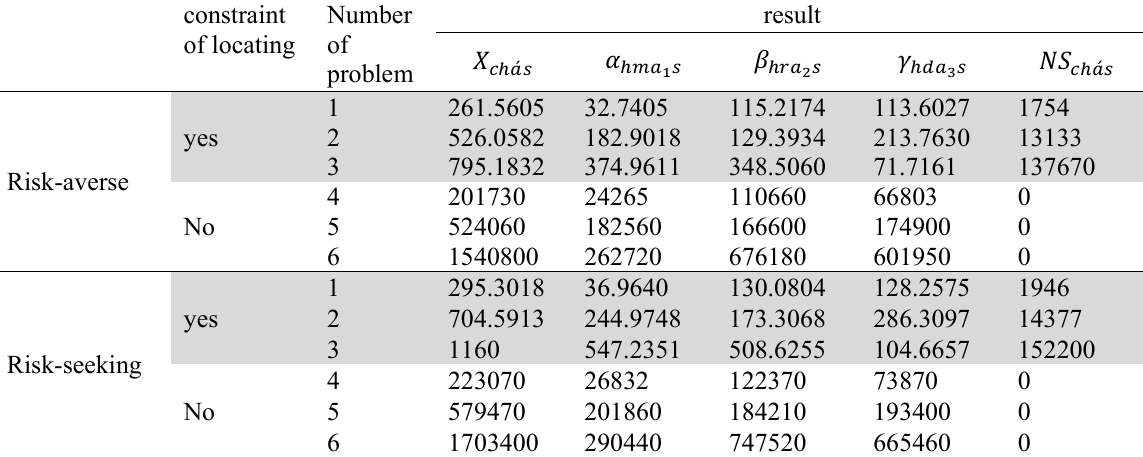
Results of the presented model under uncertainty and risk solved by MATLAB in different sizes constraint Number of locating